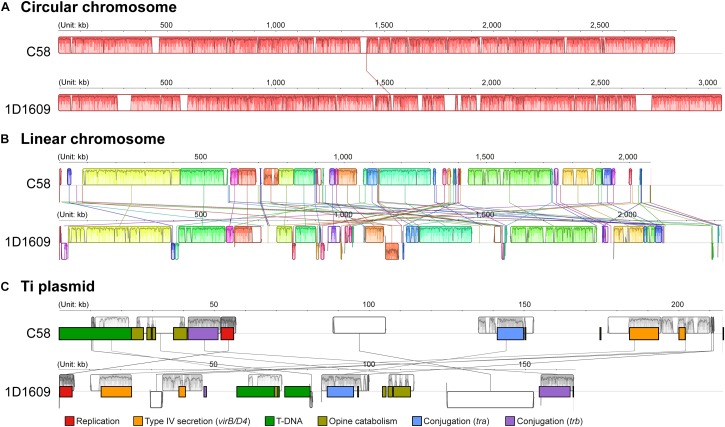
Genome alignment by replicon. (A) Circular chromosome; synteny conservation was found across the entire chromosome. (B) Linear chromosome; collinear blocks are indicated by colors and linked by lines. (C) Ti plasmid; collinear blocks are indicated by gray boxes and linked by lines, notable gene clusters are color-coded.